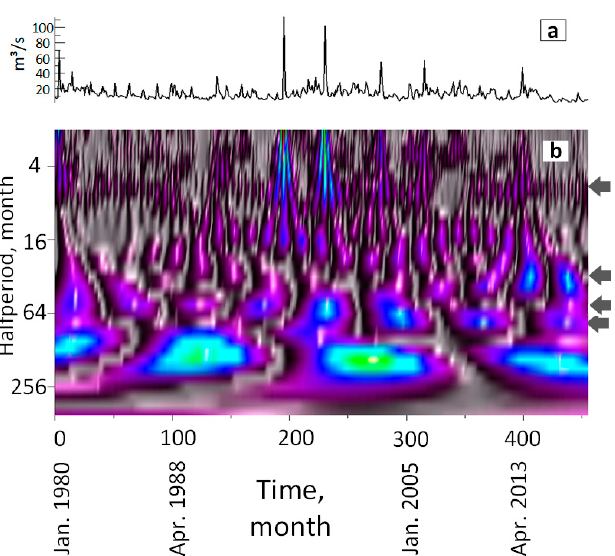
Figure 11. Wavelet-periodogram ( b ) based on the average monthly values of the Southern Bug River discharges (m 3 s − 1 ) for the period 1980–2017 at the post in the village of Lelitka ( a ). The arrows show a series of spots, allowing us to reliably determine the cyclicity period: top arrow—1 year, middle arrows—6 and 8 years, lower arrow—11 years.